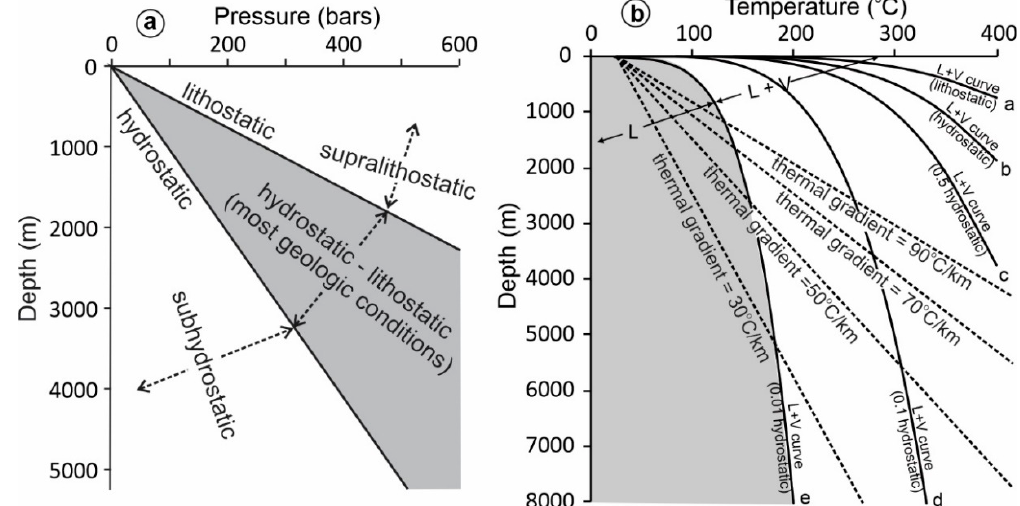
Figure 8. ( a ) Relationships between fluid pressure and depth for different pressure regimes (lithostatic, hydrostatic, subhydrostatic, supralithostatic). ( b ) Liquid–vapor curve in a depth–temperature space for a fluid with 20 wt% NaCl (computed with the program from Steele-McInnis et al. 2012 [50]) at different fluid pressure regimes (lithostatic, hydrostatic, 0.5 hydrostatic, 0.1 hydrostatic, and 0.01 hydrostatic). See text for discussion.